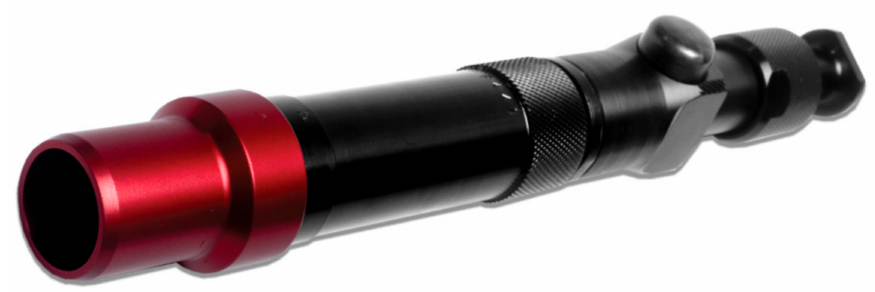
Figure 1. Accles and Shelvoke CASH Small Animal Tool. A 0.22” caliber blank cartridge-powered non-penetrating captive bolt device.